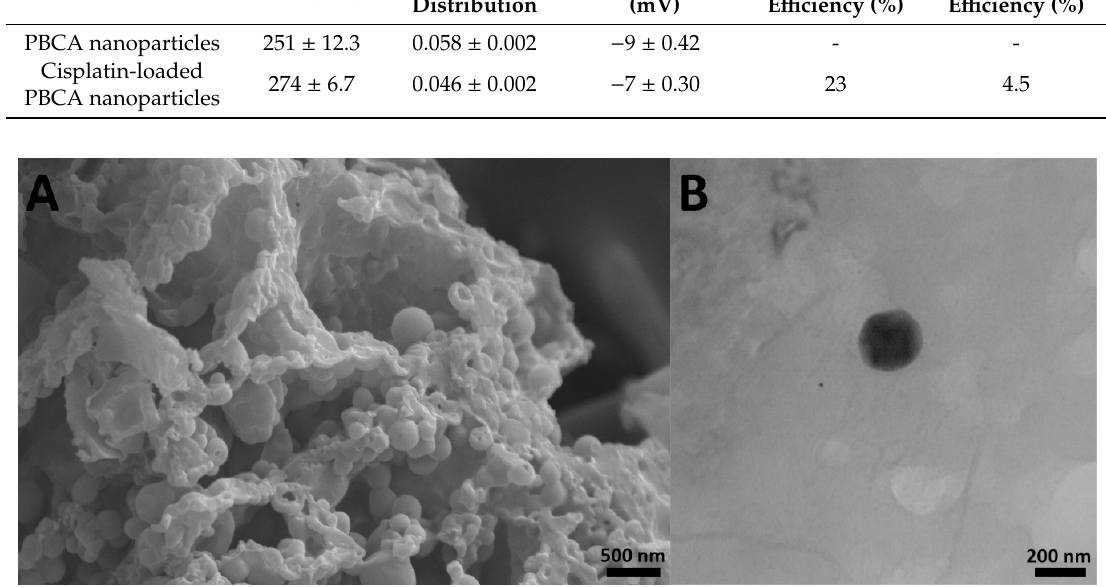
Figure 2. ( A ) scanning electron microscopy SEM and ( B ) transmission electron microscopy TEM images of cisplatin-loaded PBCA nanoparticles prepared using miniemulsion polymerization method (×15,000). Table 1. Size, size distribution, and zeta potential of blank and cisplatin-loaded PBCA nanoparticles and encapsulation and loading efficiencies of cisplatin-loaded PBCA nanoparticles.